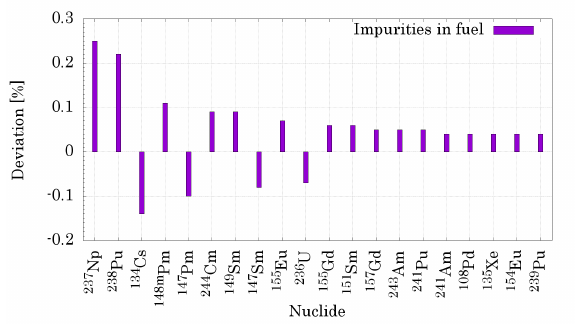
Figure 9. Effect of change in enrichment on compo- sition.